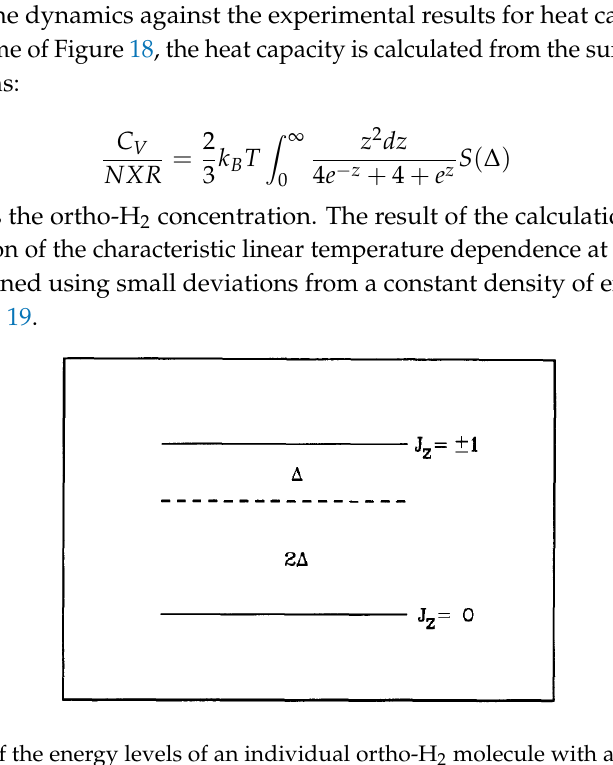
Figure 18. Sketch of the energy levels of an individual ortho-H 2 molecule with angular momentum J = 1 with the degenerate states J z = ± 1 separated from the state J Z = 0 by an energy gap 3 ∆ . Reproduced with permission from [39]. Copyright Elsevier, 1969.